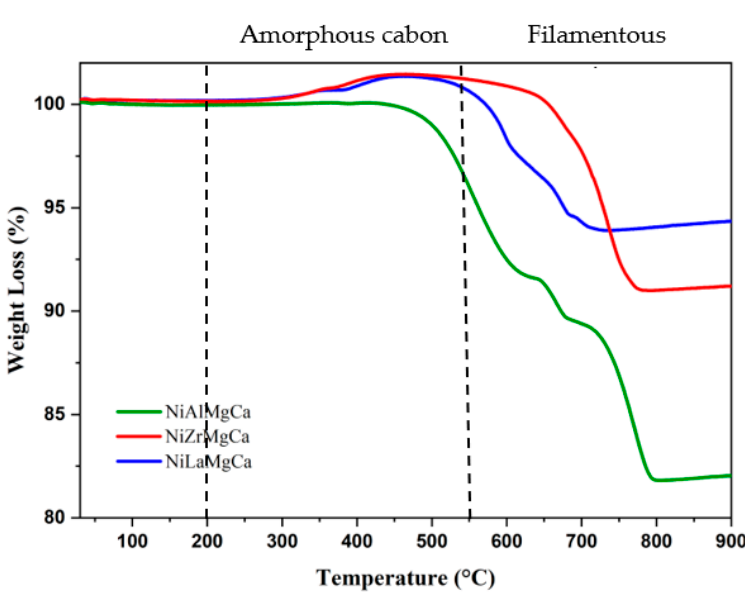
Figure 9. TGA analysis of spent catalyst after 5 h tar steam reforming .